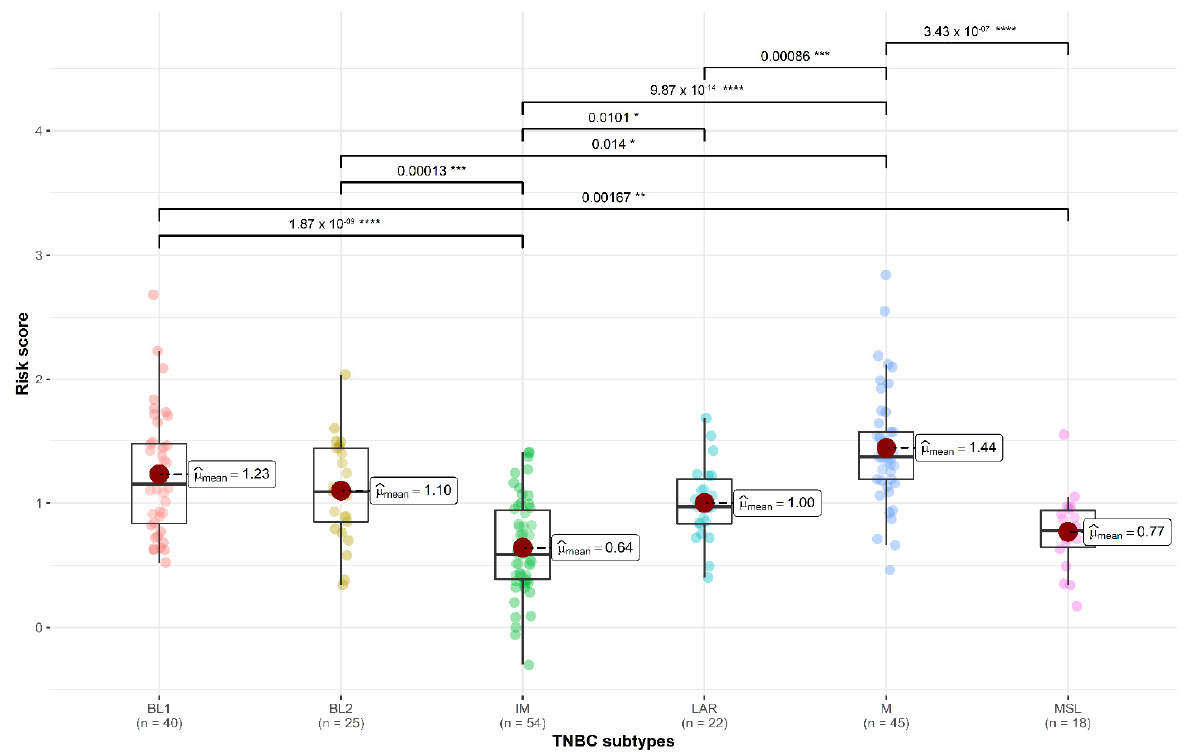
Figure 3. Distribution of the 3-genes score in each TNBC subtype. Lower values were observed in the IM and MSL subtype. Asterisks represent statistical significance (* p < 0.05, ** p < 0.01, *** p < 0.001, **** p < 0.0001).